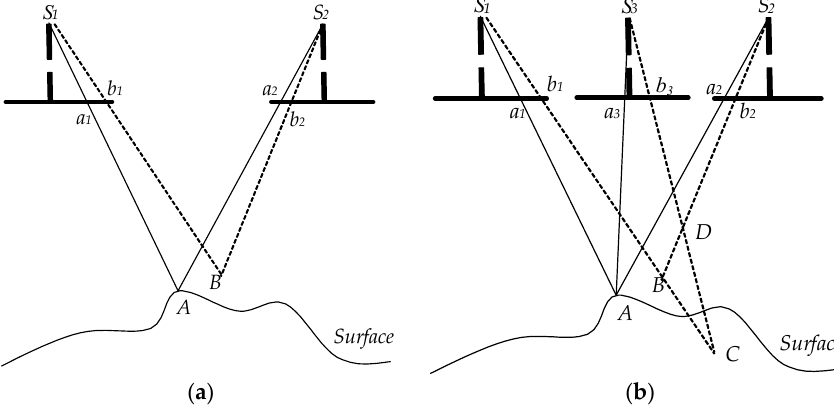
Figure 1. Schematic diagram showing correction of distortion independent of (GCPs). ( a ) Two images are insufficient to detect image distortion; ( b ) three images can detect image distortion.